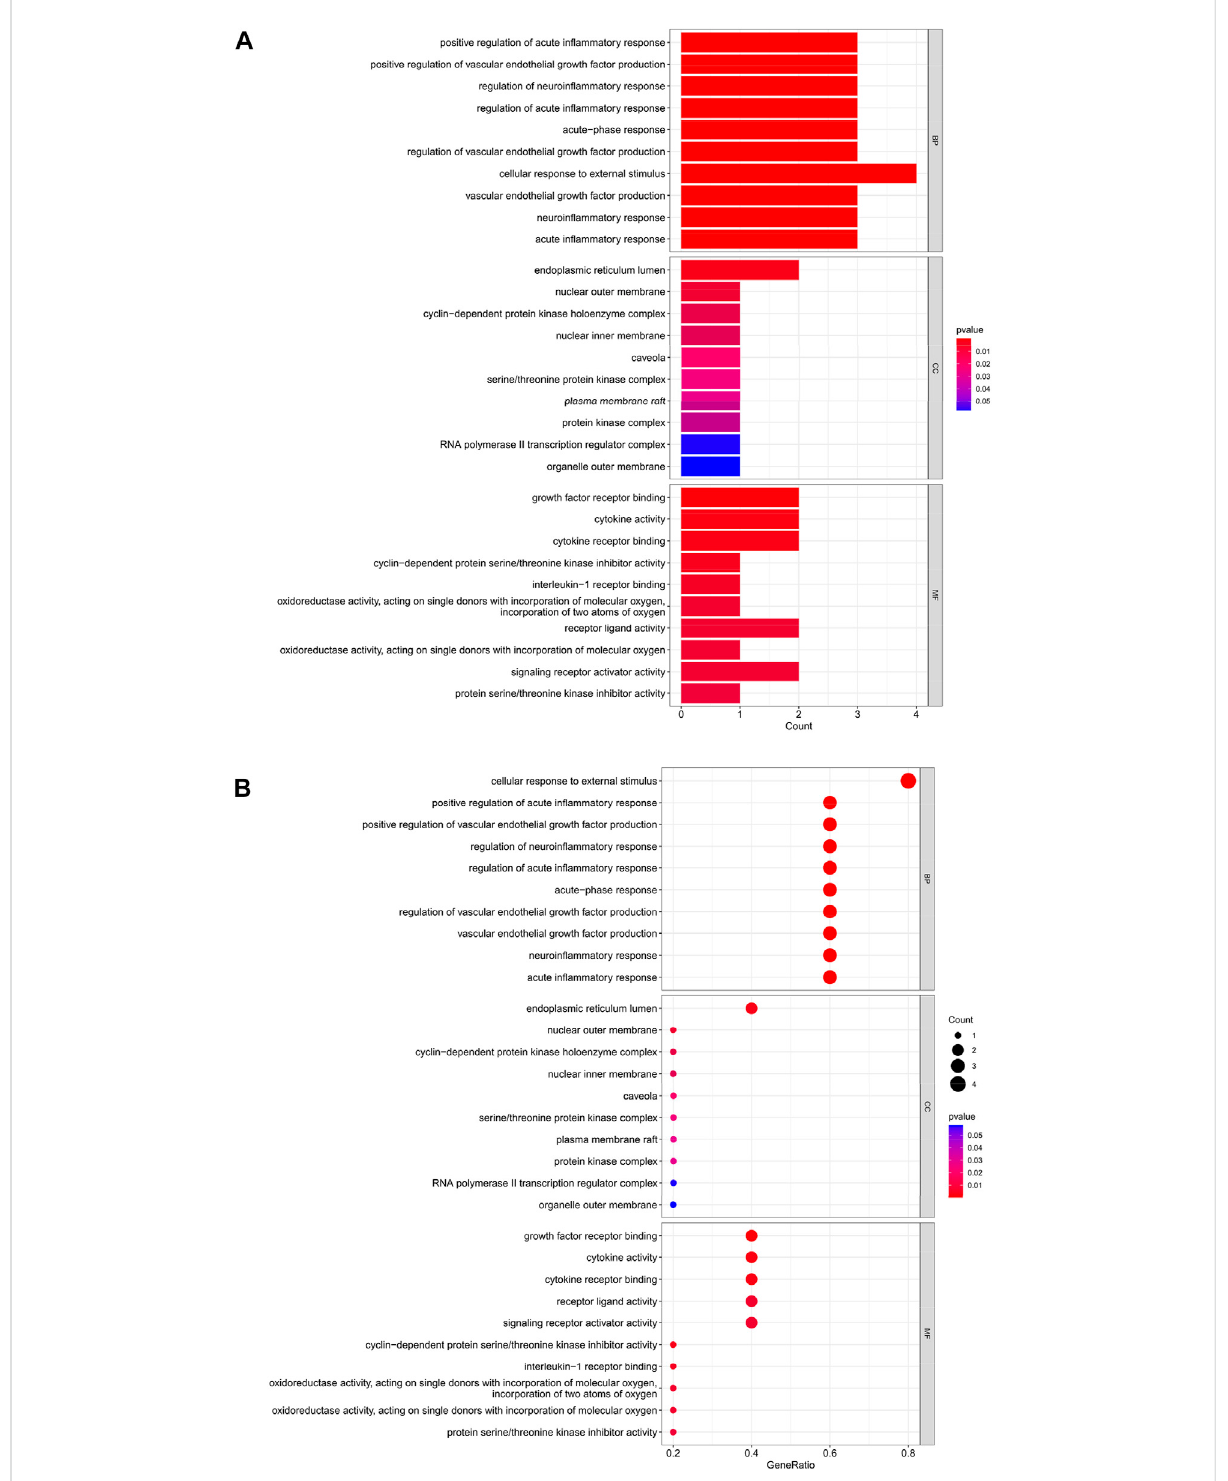
FIGURE 6 (A) Bar chart plotted against the results of GO analysis for the Hub gene, (B) Bubble chart plotted against the results of GO analysis for the Hub